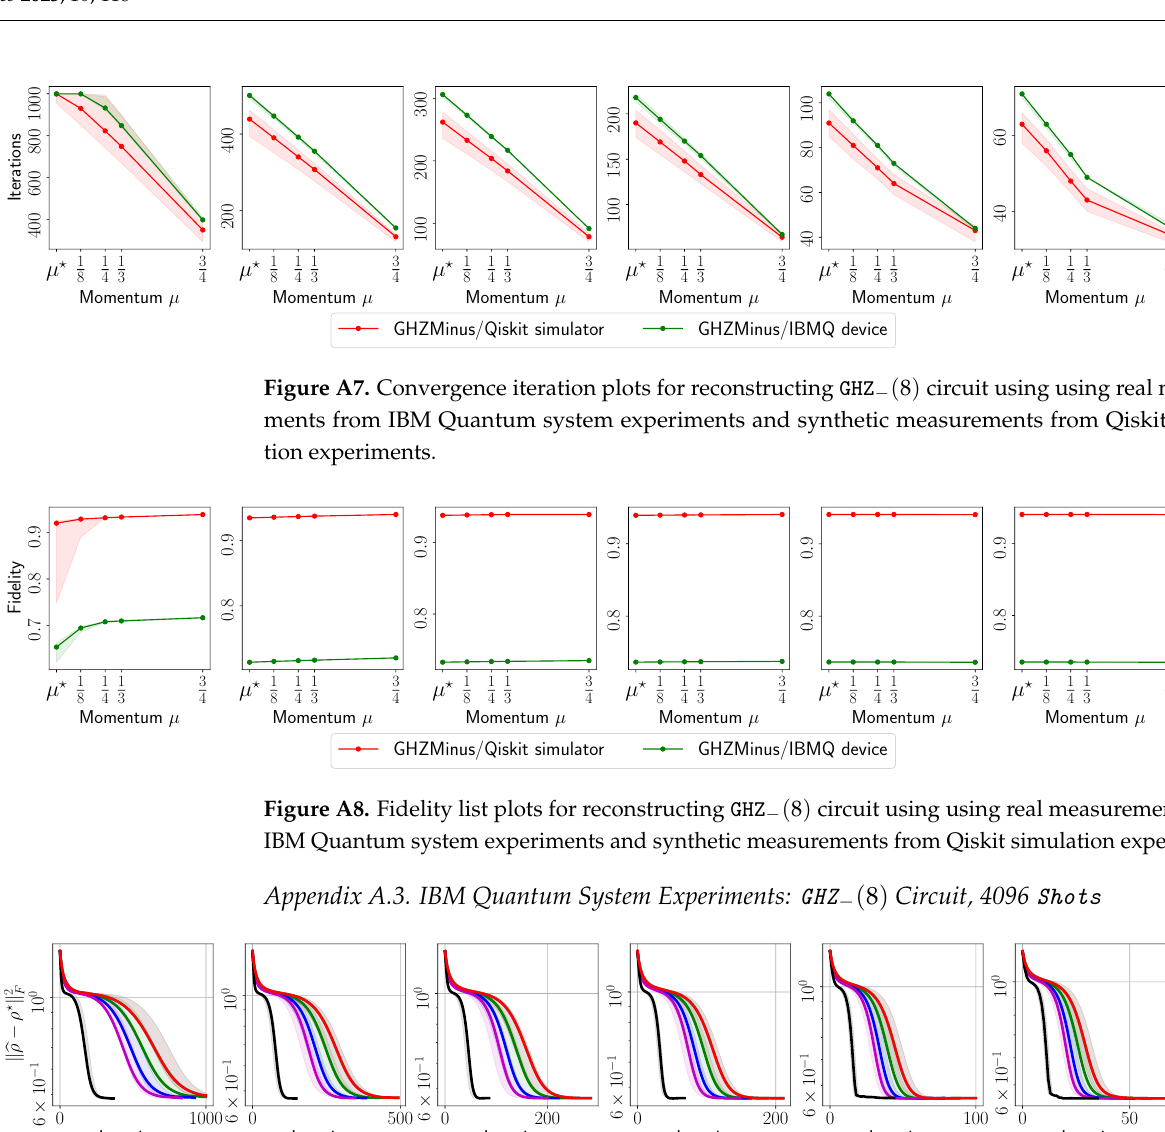
Figure A9. Target error list plots for reconstructing GHZ IBM Quantum system experiments.